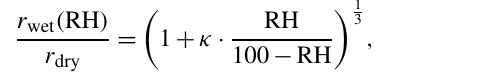
Figure 1 outlines the OMCAM retrieval algorithm for esti- mating CCN concentrations from CALIPSO